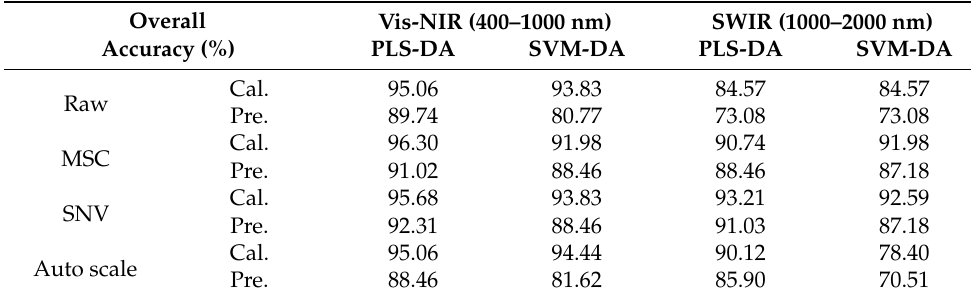
Table 2. Comparison of PLS-DA and SVM-DA models based on the raw, MSC, SNV and Auto scale